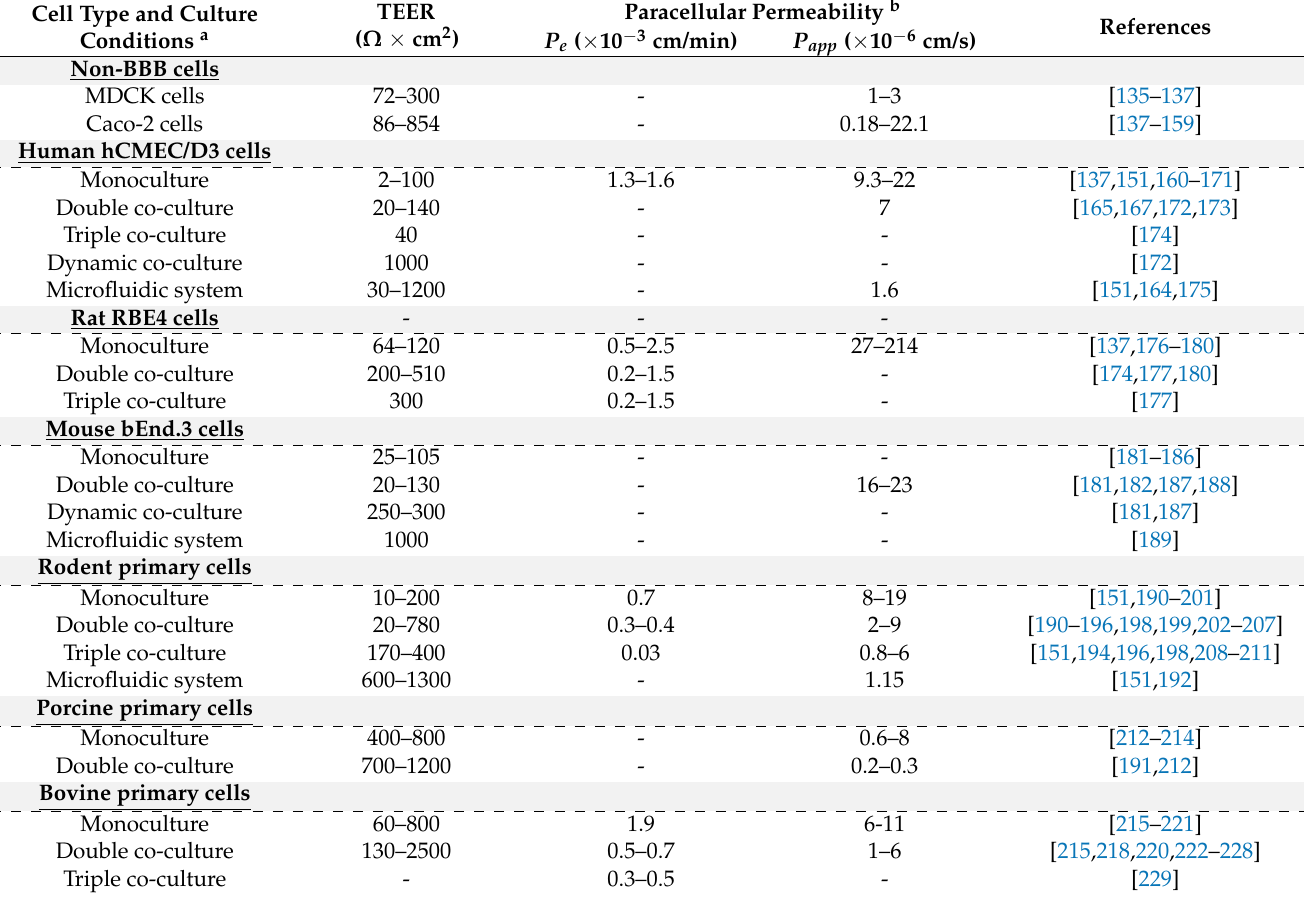
Table 1. Range of reported TEERs and paracellular permeabilities of different in vitro BBB